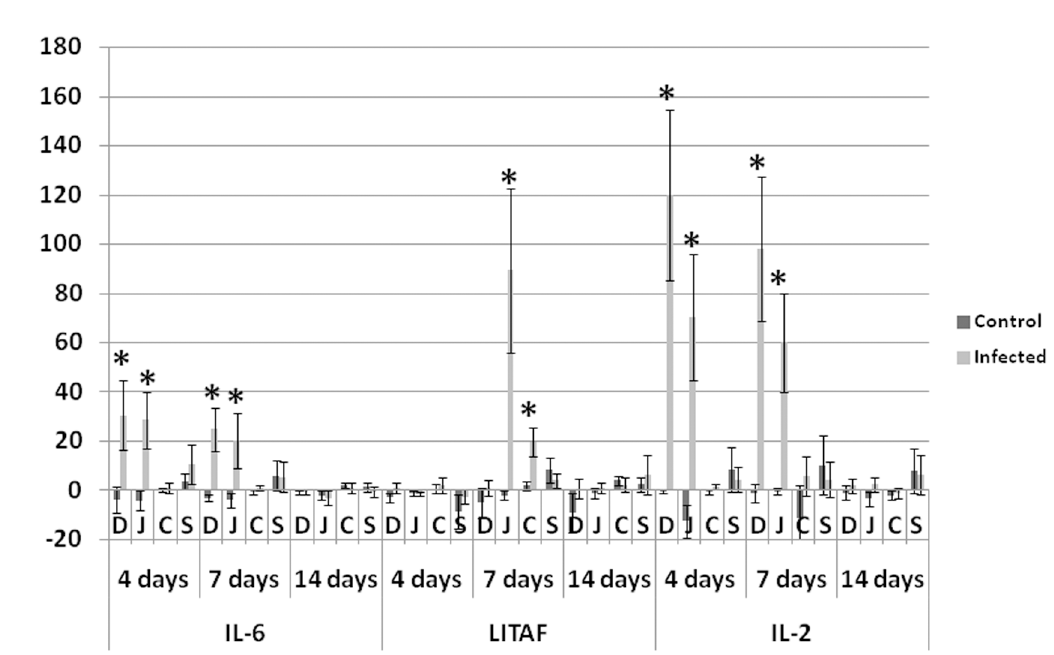
Fig 6. Fold change in proinflammatory cytokines (IL-6 and LITAF) and IL-2. IL-6 and IL-2 are significantly elevated in dudenum and jejunum of infected birds at 4 and 7 dpi. LITAF has significantly higher fold increase in infected birds compared with non-infected control in jejunum and cecum at 7 dpi. D : duodenum, J : jujenum, C : cecum, S spleen, Days refers to number of days post inoculation (dpi). Analyses were performed in duplicate (Five turkeys/group at each time point) and values are mean + 3SD. * Difference between infected group and non-infected groups within the same organ are significant (P < 0.05).